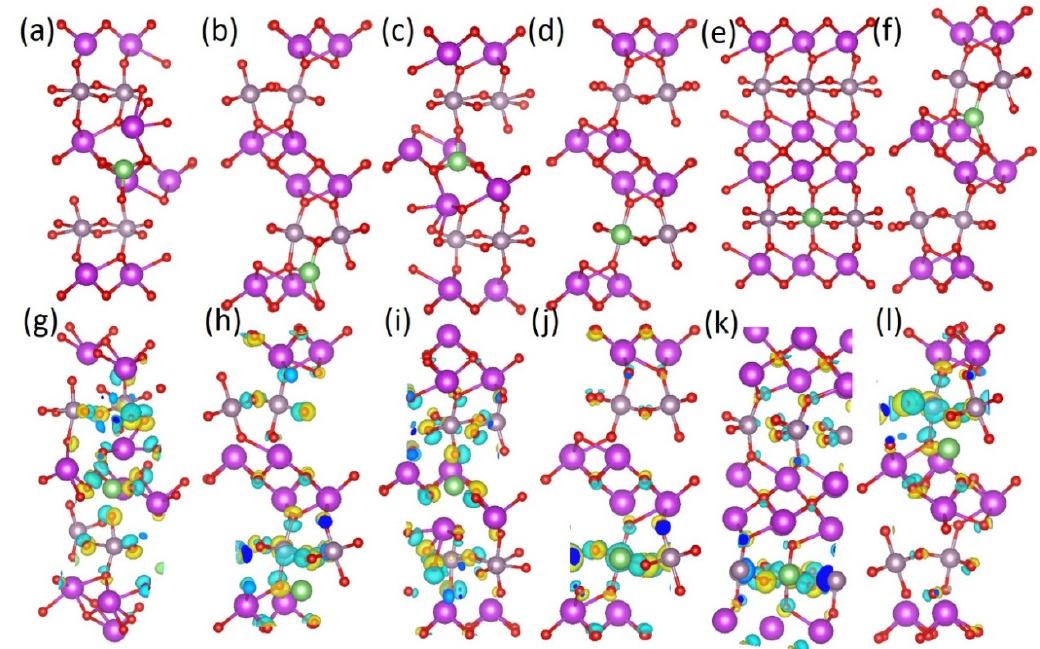
Figure 9. Calculated atomic scale models of Li interstitial in Bi 2 MoO 6 at ( a ) site 1, ( b ) site 2, ( c ) site 3, ( d ) site 4, ( e ) site 5, and ( f ) site 6, and charge density difference as a result of Li interstitial at ( g ) site 1, ( h ) site 2, ( i ) site 3, ( j ) site 4, ( k ) site 5, and ( l ) site 6 in Bi 2 MoO 6 . The site numbering refers to Table 2. Purple spheres are Bi, grey Mo, green Li, and red O. Yellow iso-surface represents an increase in charge density upon lithium substitution, whereas blue iso-surface represents depletion of charge density.